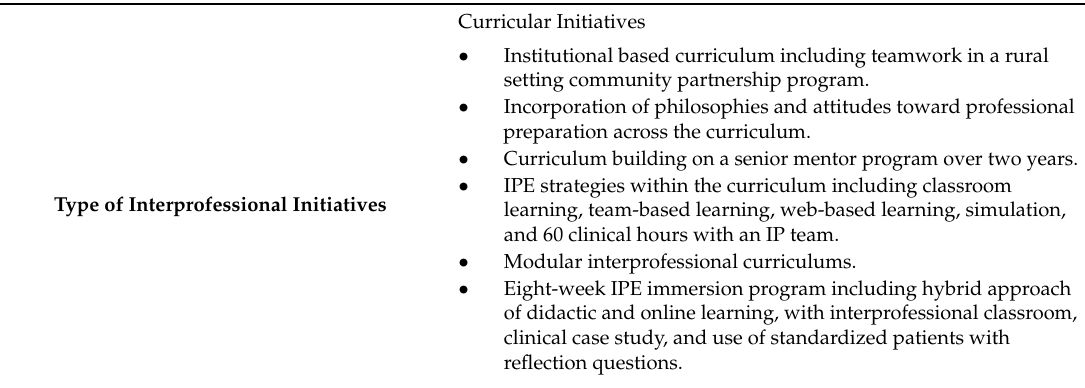
Table 2. Processes Related to IPC in Health Care